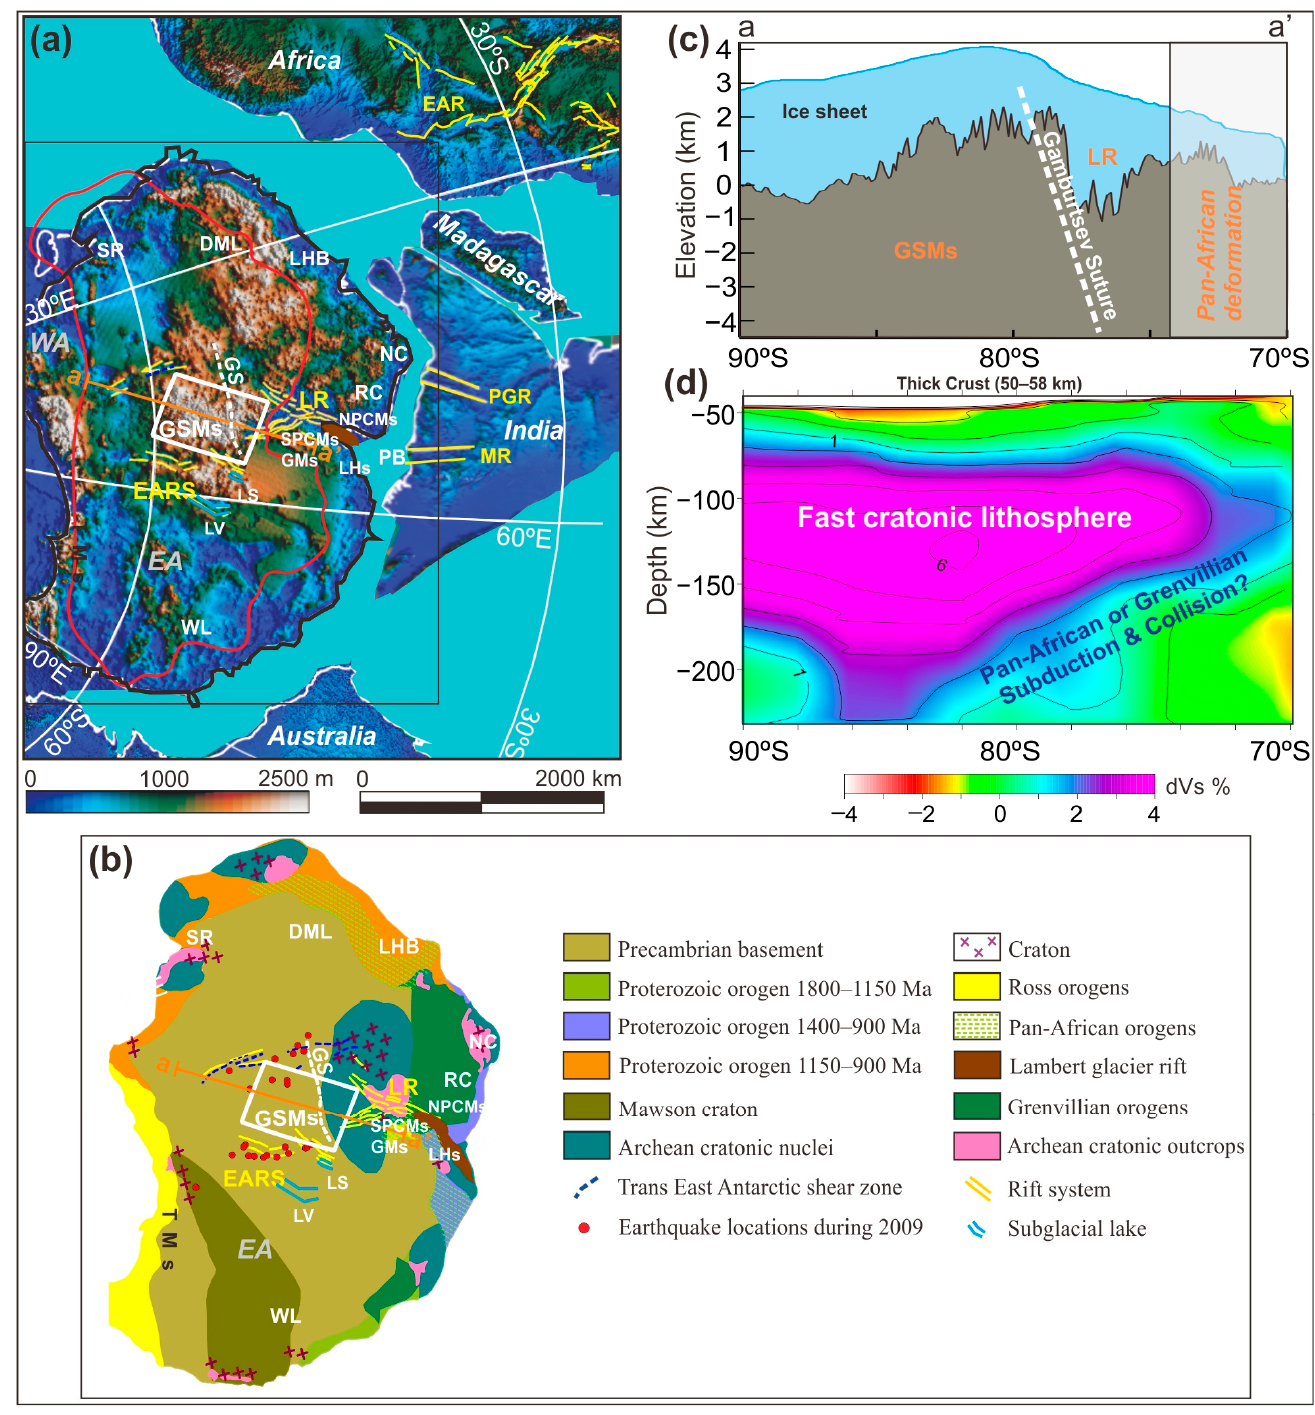
Figure 1. East Antarctica in Gondwana and seismic tomography through the GSMs [6,28]. ( a ) The central position of East Antarctica within the Gondwana supercontinent at 140 Ma. ( b ) Geological map of East Antarctica. This geological map is modified from Grikurov and Leitchenkov (2019), [29] and Kleinschmidt (2021) [30]. The white rectangle is the study area. The orange line is the location of the seismic topography model shown in ( c ). The red line is the extent of the fast cratonic lithosphere in East Antarctica at 150 km depth. Yellow lines denote the East Antarctic Rift System wrapping around the GSMs and including the Lambert Rift. Note the Gamburtsev Suture (dashed white line). The red dots are earthquakes detected by the AGAP/GAMSEIS seismic array during 2009 [27].